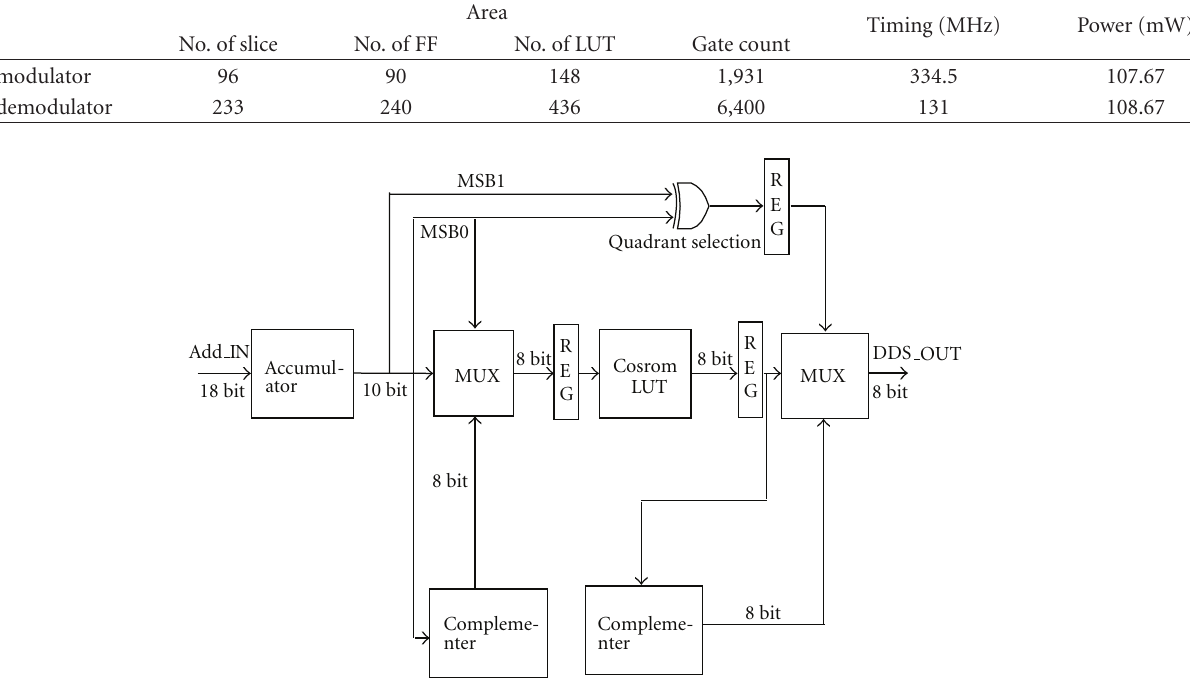
Figure 11: Block diagram of a pipelined ROM-based direct digital synthesizer. Table 3: Detailed power analysis results for 2vp30-7 ff